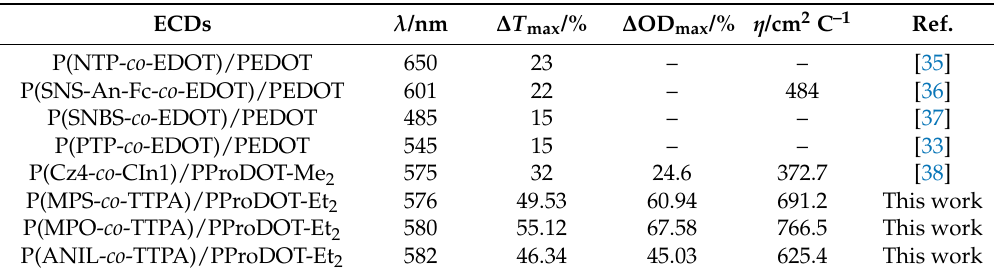
Table 7. The transmittance changes and coloration efficiency of